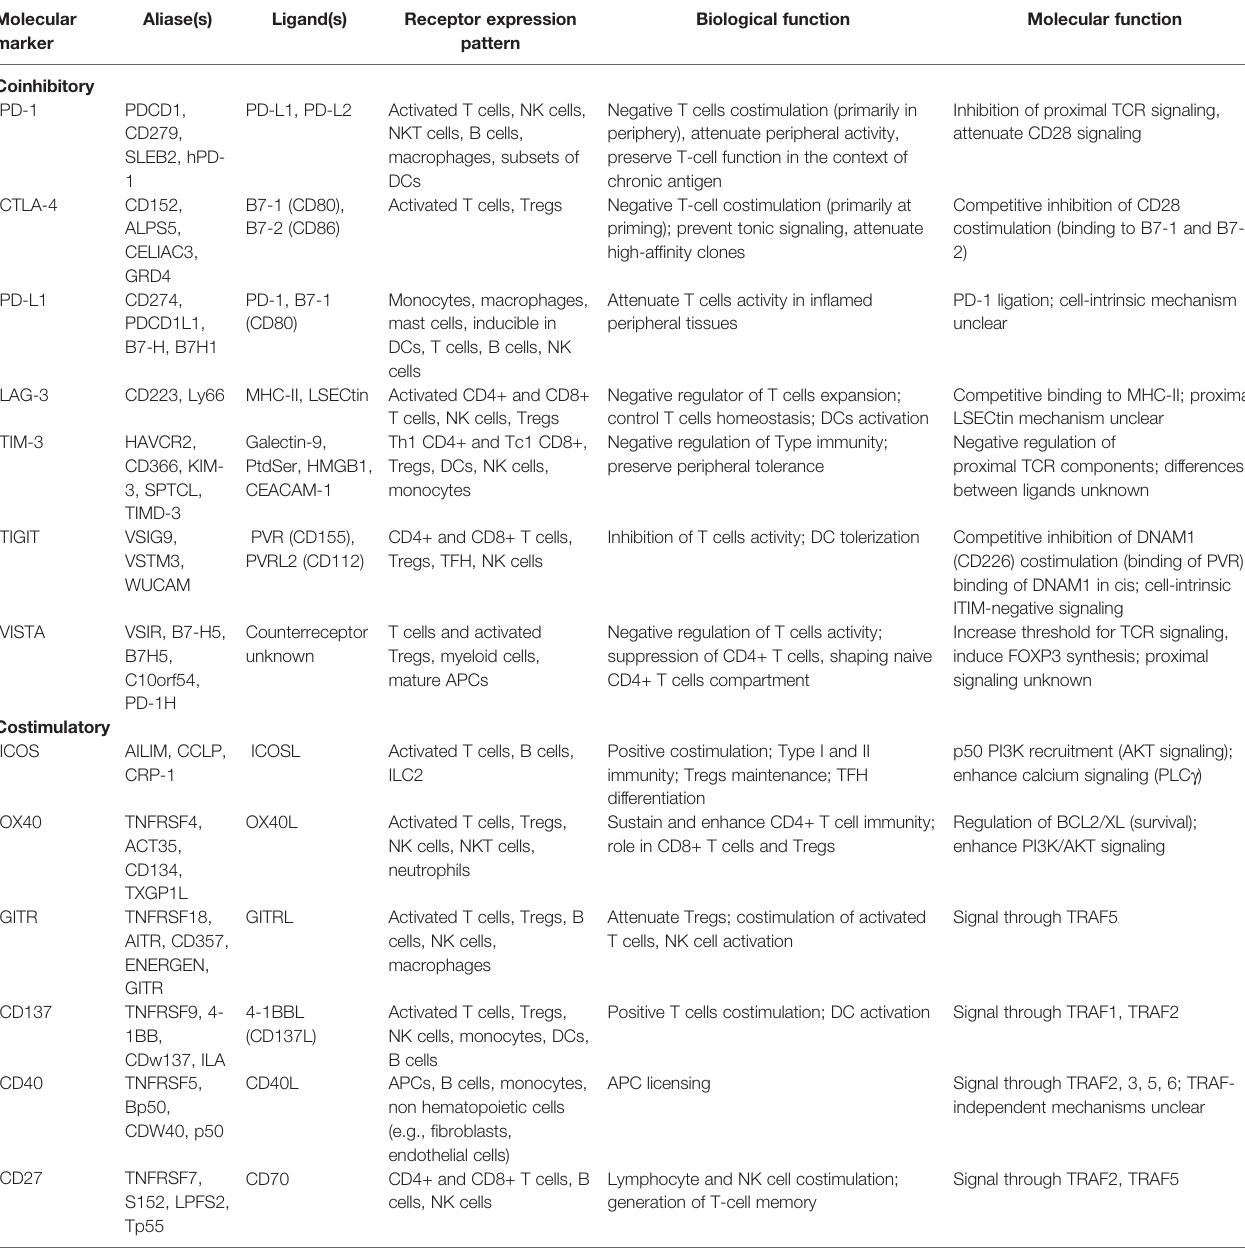
Biological function Molecular